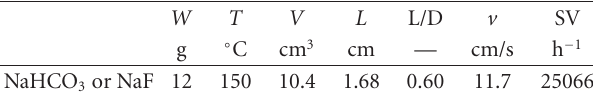
Table 4: Experimental conditions of the fixed-bed furnace. W T V L L/D v SV g ◦ C cm 3 cm — cm/s h − 1 NaHCO 3 or NaF 12 150 10.4 1.68 0.60 11.7